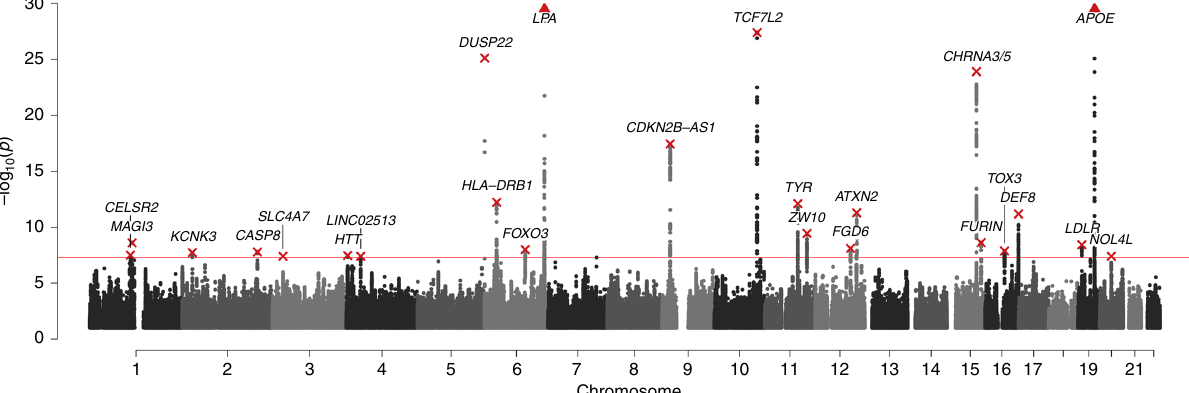
Fig. 2 Twenty-four multivariate loci identi fi ed at genome-wide signi fi cance. Manhattan plot showing the nominal strength of association − log 10 ( P value) (two-sided) on the y -axis against the chromosomal position of SNPs on the x -axis, where the null hypothesis is no association with healthspan, parental lifespan, and longevity. The red line represents the genome-wide signi fi cance threshold (5 × 10 – 8 ). Annotated are the nearest gene(s) to the lead SNP (in red) of each locus. The y -axis has been capped at 5 × 10 − 30 to aid legibility; SNPs passing this cap are represented as triangles: LPA , P = 3.8 × 10 − 30 , APOE , P = 9.6 × 10 − 127